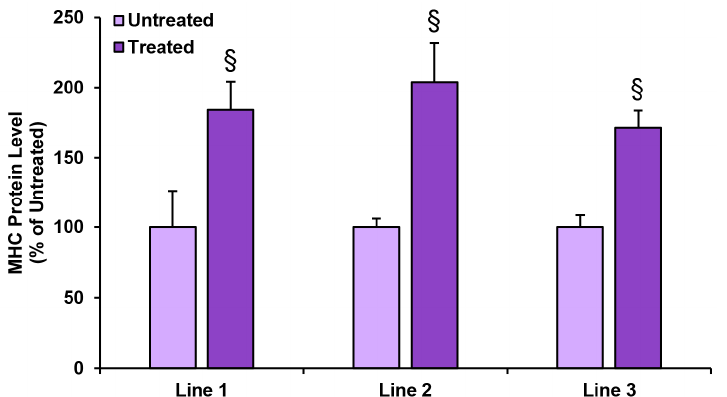
Figure 6. Levels of MHC protein detected in hSCs differentiated in myotubes, treated or not with 10 − 7 mol/L PTH (1-84) for 30 min, after 6 days of myogenic differentiation. Values of MHC protein, normalized on total protein content and expressed as percentage of untreated myotubes (control), are the mean ± SD of three experiments repeated in quadruplicate. Student’s t -test analysis. § p ≤ 0.01 compared to related untreated line.